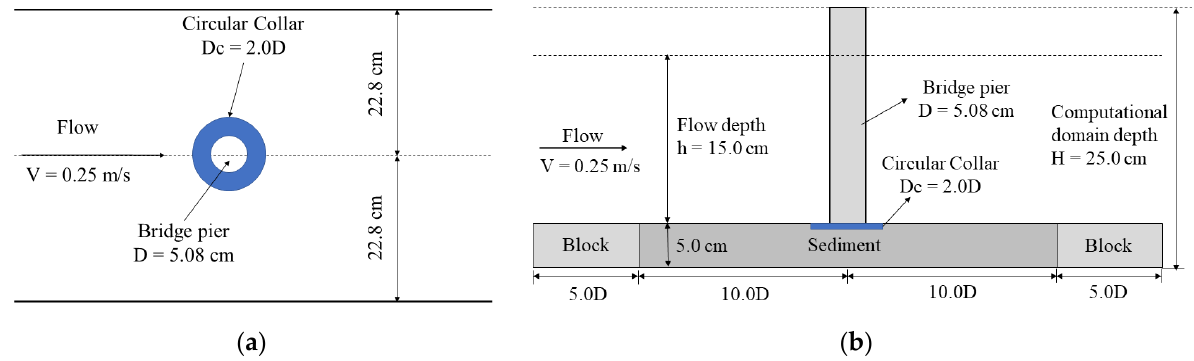
Figure 6. The layout of the model with a circular collar. ( a ) The layout of the flume (top view). ( b ) The layout of the computational domain (side view).